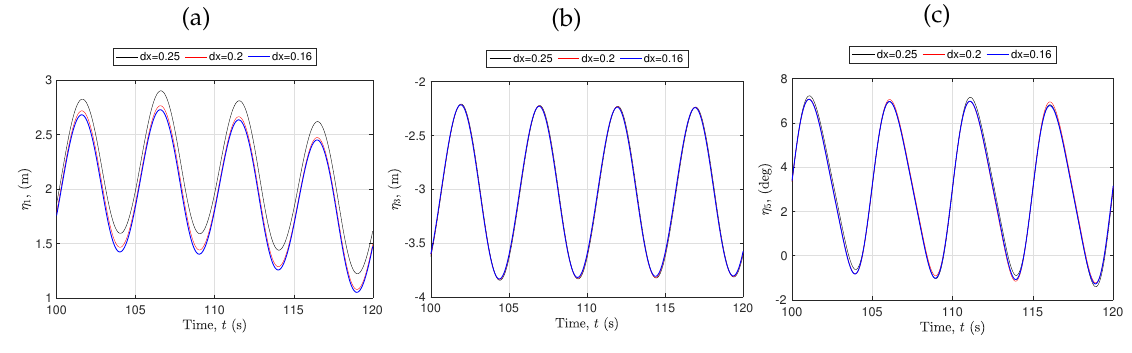
Figure 3. Mesh dependence of motion response in ( a ) surge, ( b ) heave, and ( c )